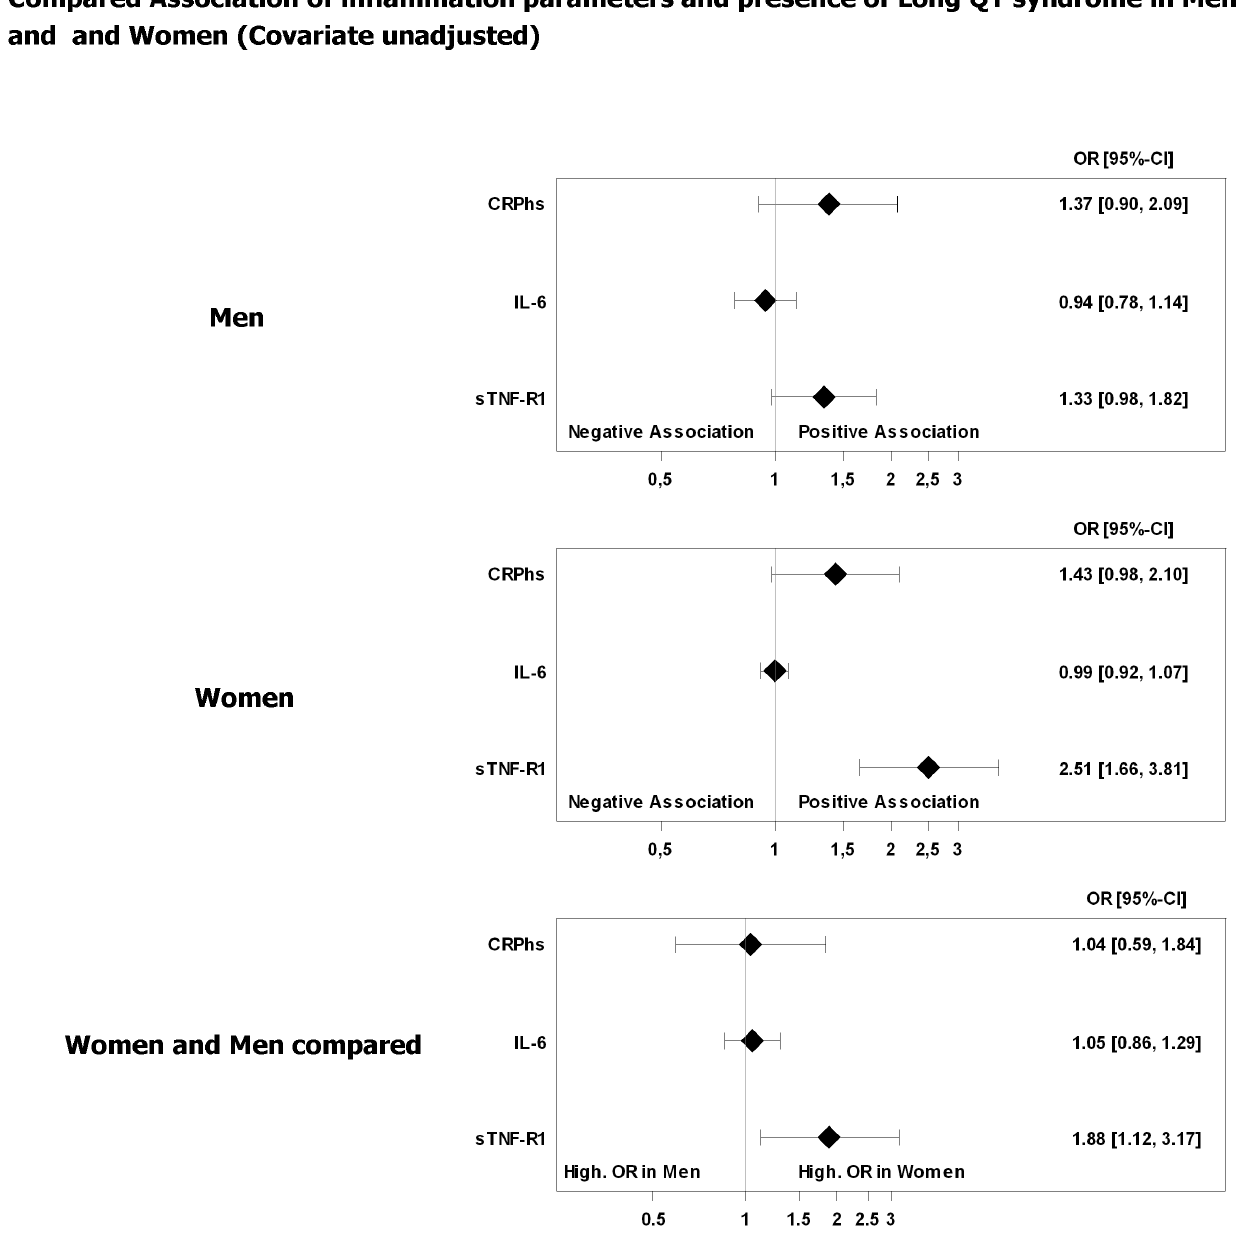
Figure 1. Association of prolonged QTc time and inflammation parameters. Odds ratios (OR) with 95% confidence interval. Unadjusted regression models of inflammation parameter. OR refers to a 1,000 pg/mL increase in sTNF-R1, a 10 pg/mL increase in IL-6, and a 10 mg/L increase in hsCRP.